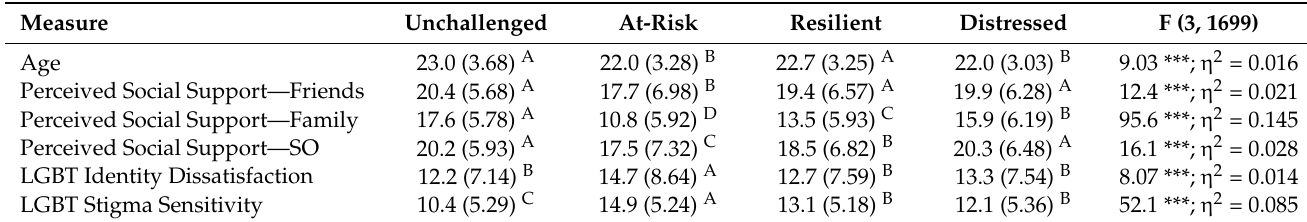
Table 4. Means and standard deviations of age and internal and external protective resources for each